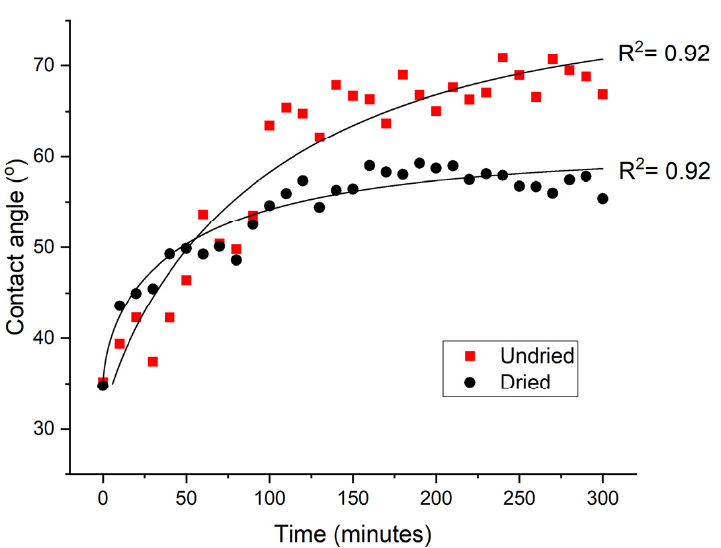
Figure 11. Ageing of dried and undried GFPA6 surface represented by contact angles after μ Plasma modification.